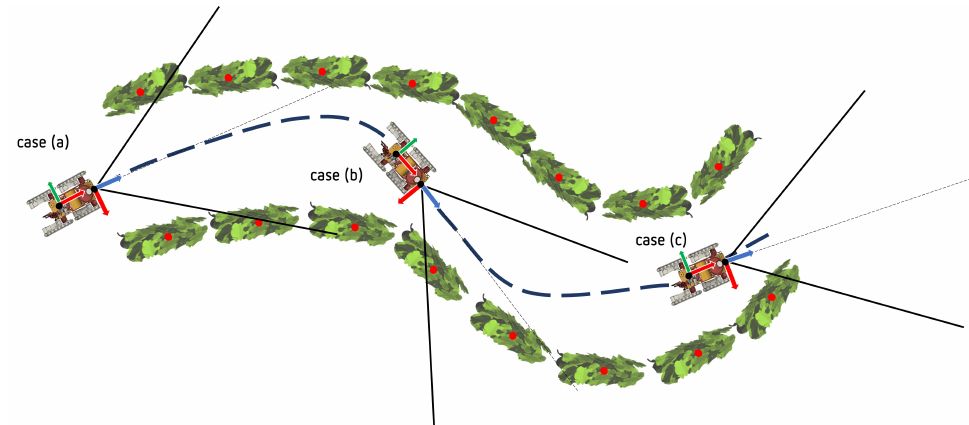
Figure 4. A sketch of robot navigation through the aisle. Example of a vineyard aisle setup with three positions of the robot and the field of view of the camera. When navigating through a vineyard, a row of vines may be outside the field of view. In case (a), only one side of the aisle is visible. In case (b), both sides are in the field of view. In case (c), only one vine trunk is in the robot’s field of view because of the end of the aisle. The centerline of the robot’s field of view is also a tangent to the path. The positions of the vine trunks are marked with a red